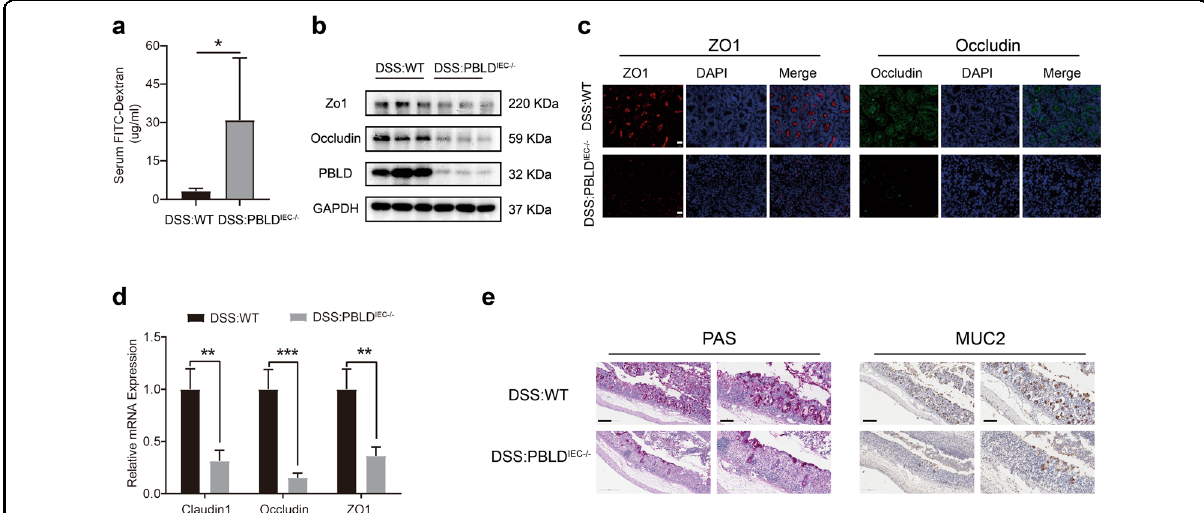
Fig. 3 Epithelial PBLD de fi ciency impairs intestinal barrier function in mice with DSS-induced colitis. a Intestinal permeability was evaluated by measuring the concentration of fl uorescein isothiocyanate (FITC)-dextran in the blood serum of wild-type (WT) and PBLD IEC − / − mice after treatment with DSS for 5 days followed by 3 days regular drinking water ( n = 6). Data are mean ± standard deviation (SD). * p < 0.05. b Western blot analysis of proteins in whole-colon tissue samples from mice with DSS-induced colitis. c Immuno fl uorescent staining of ZO-1 and occludin in colonic sections from WT and PBLD IEC − / − mice with colitis. Scale bars: 50 μ m. d qRT-PCR analysis of claudin-1, occludin, and ZO-1 mRNA levels in colonic tissue samples from WT and PBLD IEC − / − mice with colitis ( n = 4). Data are mean ± SD. *** p < 0.001. e Periodic acid – Schiff (PAS) and mucin 2 (MUC2) staining of colonic sections from WT and PBLD IEC − / − mice with colitis. Images are representative from four mice in each group. Scale bars: 200 μ m in left, 100 μ m in